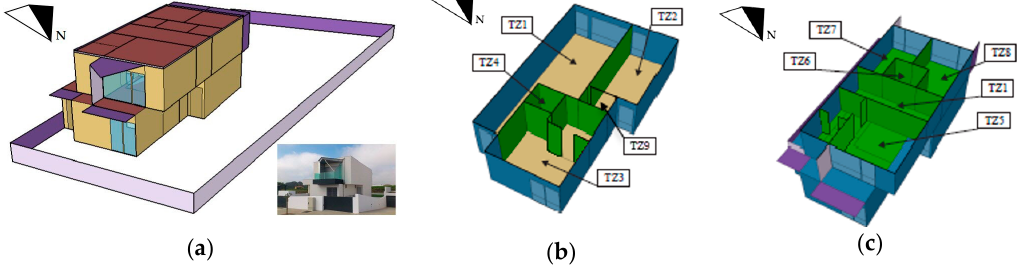
Figure 11. 3D model definition: ( a ) Building energy model geometry; ( b ) thermal zones division—ground floor; ( c ) thermal zones division—first floor.